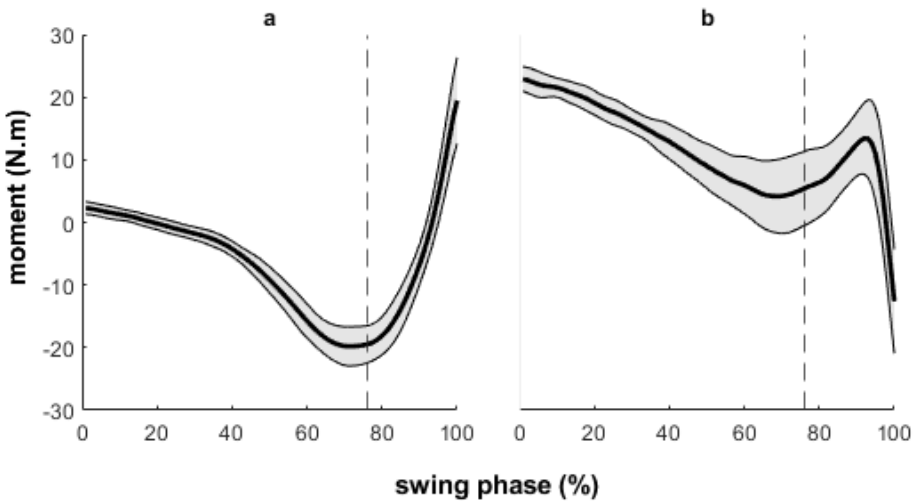
Figure 4. Normalised time histories for wrist resultant moments; ( a ). Wrist flexion [+]/extension [ − ], and ( b ). Wrist ulnar deviation [+]/radial deviation [ − ]. Vertical dashed line indicates the mean end of back swing instant (Figure 1).